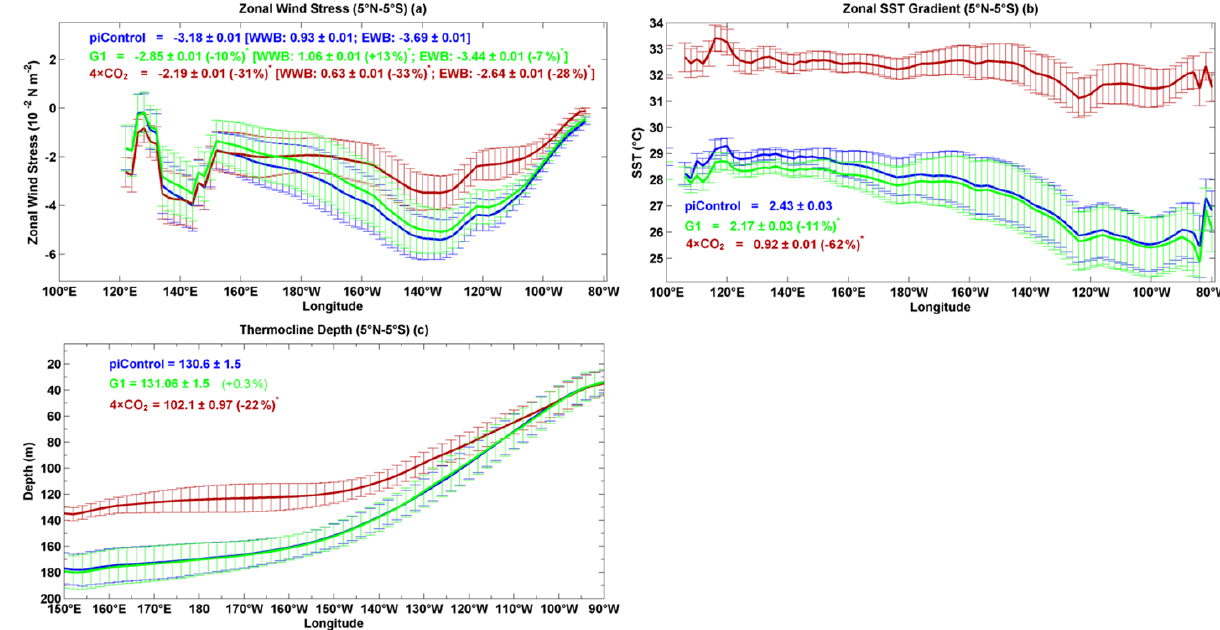
Figure 4. DJF mean climatology of (a) zonal wind stress, (b) zonal SST gradient, and (c) thermocline depth. Error bars indicate ± 1SD calculated over the simulated period. Numbers with an asterisk indicate that the percentage change is statistically significant at 99%cl. Table 1. Eastern Pacific ENSO amplitude. Experiment Amplitude Difference w.r.t. SD